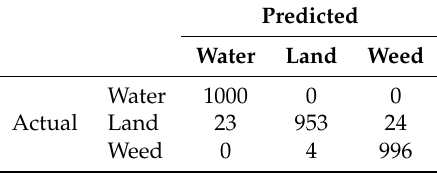
Table 5. Error matrix for the 2 July untreated channel (U) image using optimum classification parameters.